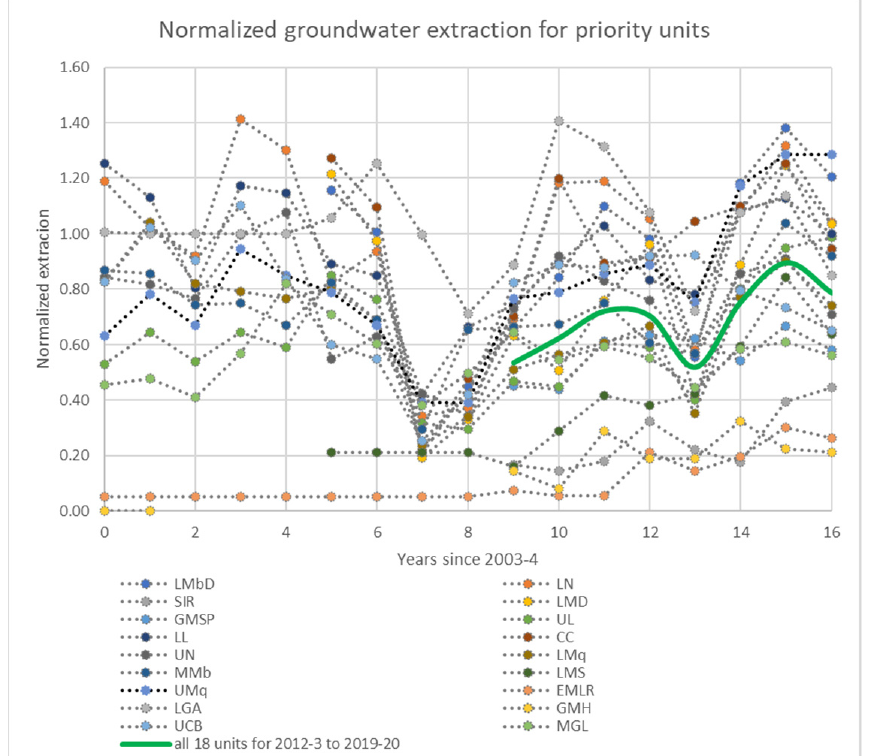
Figure 3. Annual groundwater extraction (GL/year) for the 18 priority groundwater units and for the aggregate of these, normalized with respect to the SDL, as annual time series for available data since 2003–2004. The continuous green line shows the result for the aggregate for the period of 2012–2013 to 2019–2020.